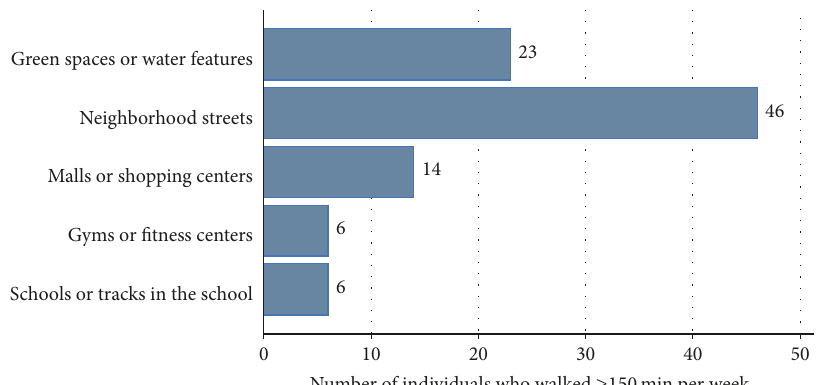
Figure 2: Places for walking for any purpose by middle-aged and older overweight and obese individuals who walked ≥ 150 minutes per week.